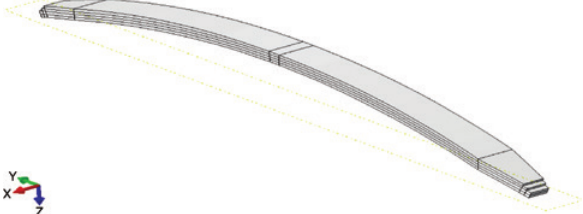
Figure 3: Final shape of the solid part.